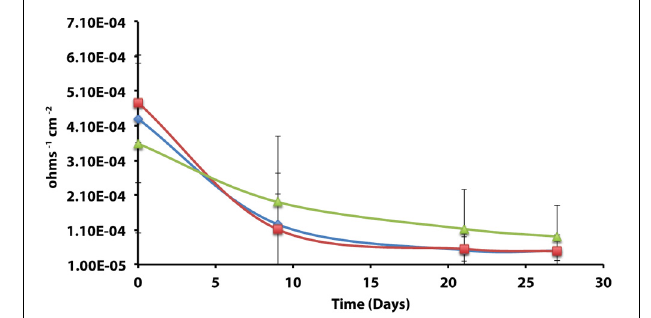
FIGURE 5 | Instantaneous corrosion rates (1/ Rp ) for axenic incubations of Desulfovibrio sp . strain G11 cultured autotrophically on 138 kPa of H 2 /CO 2 ( ) and hydrogen from the metal surface ( ), as well as an uninoculated basal medium controls ( ) amended with 138 kPa of H 2 /CO 2 or N 2 /CO 2 (standard deviation incubations n = 3, medium controls n =